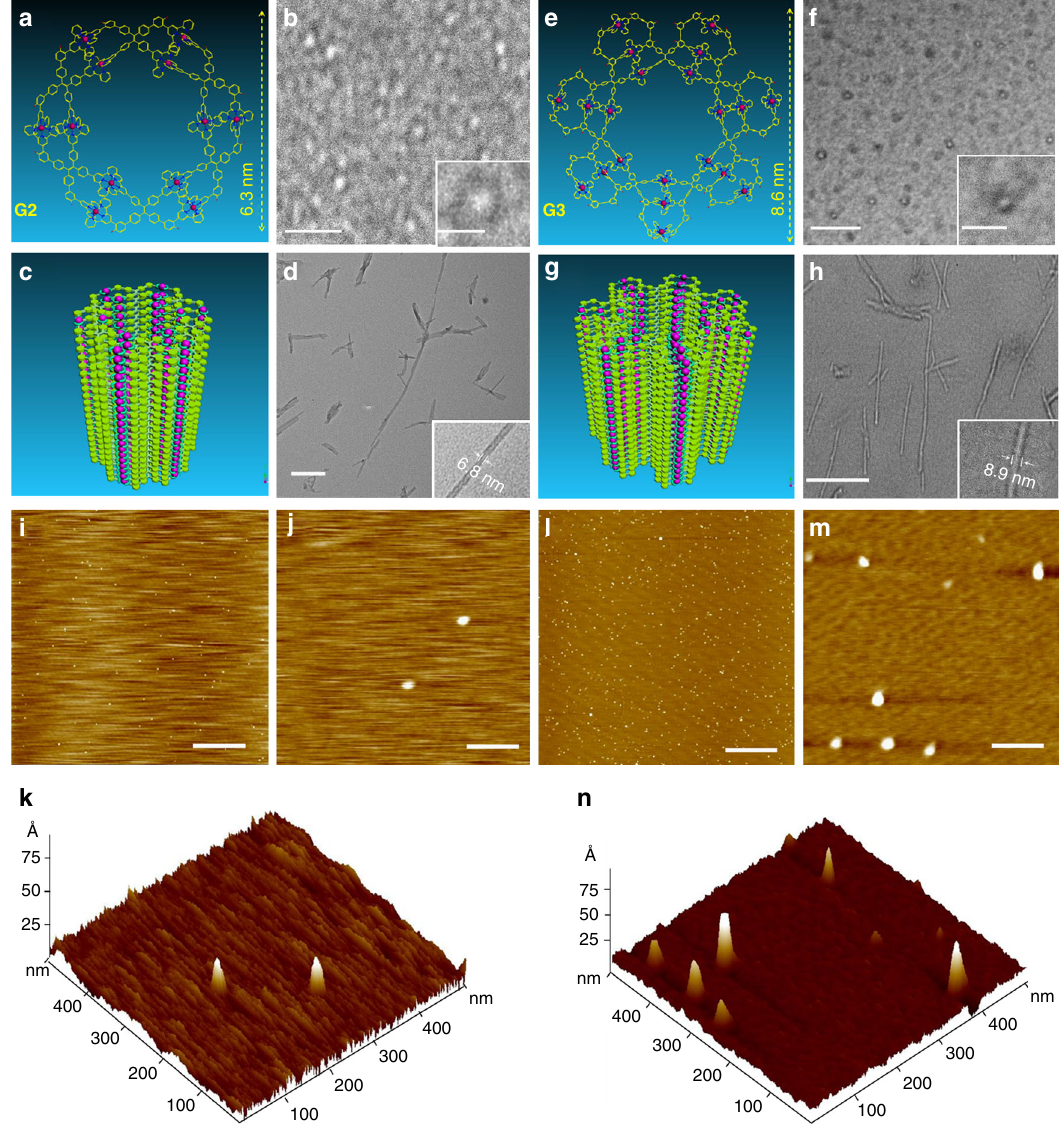
Fig. 4 TEM and AFM images of G2 and G3 . Representative energy-minimized structure from molecular modeling of a G2 and e G3 (alkyl chains are omitted for clarity); TEM images of single molecular b G2 (scale bar, 30 nm and 10 nm for zoom-in image) and f G3 (scale bar, 100 nm and 30 nm for zoom-in image); proposed stacking structure of c G2 and g G3 ; TEM images of nanotubes assembled by d G2 (scale bar, 200 nm) and h G3 (scale bar, (scale bar, 2 μ m and 100 nm, respectively); 3D AFM images of k G2 and n